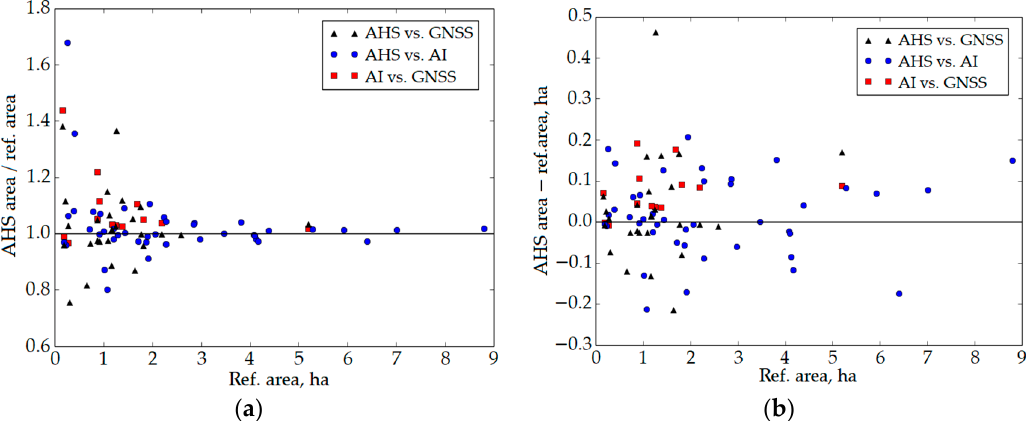
Figure 11. The area correspondence of harvested stands with respect to the references: ( a ) the relative areas; and ( b ) the differences of areas. In addition, the mutual comparison of GNSS and aerial image references is shown.